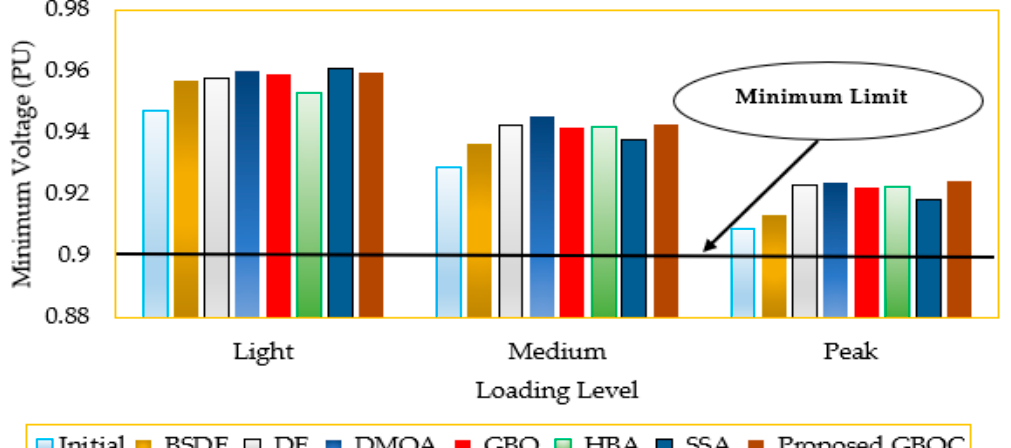
Figure 14. Minimum voltages for the IEEE 69-node system of the GBOC versus GBO, SSA, DMOA, DE, and HBA for Scenario 1.